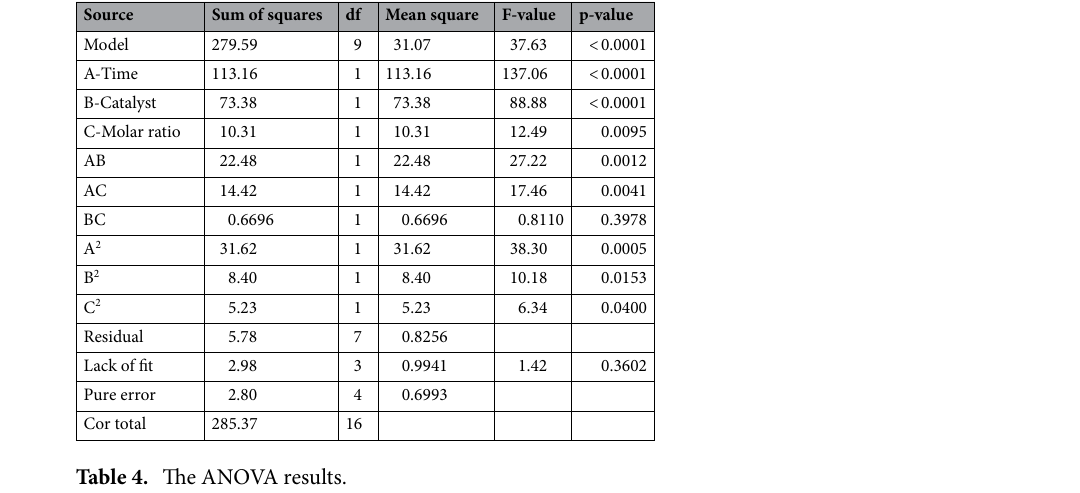
Table 4. The ANOVA results.